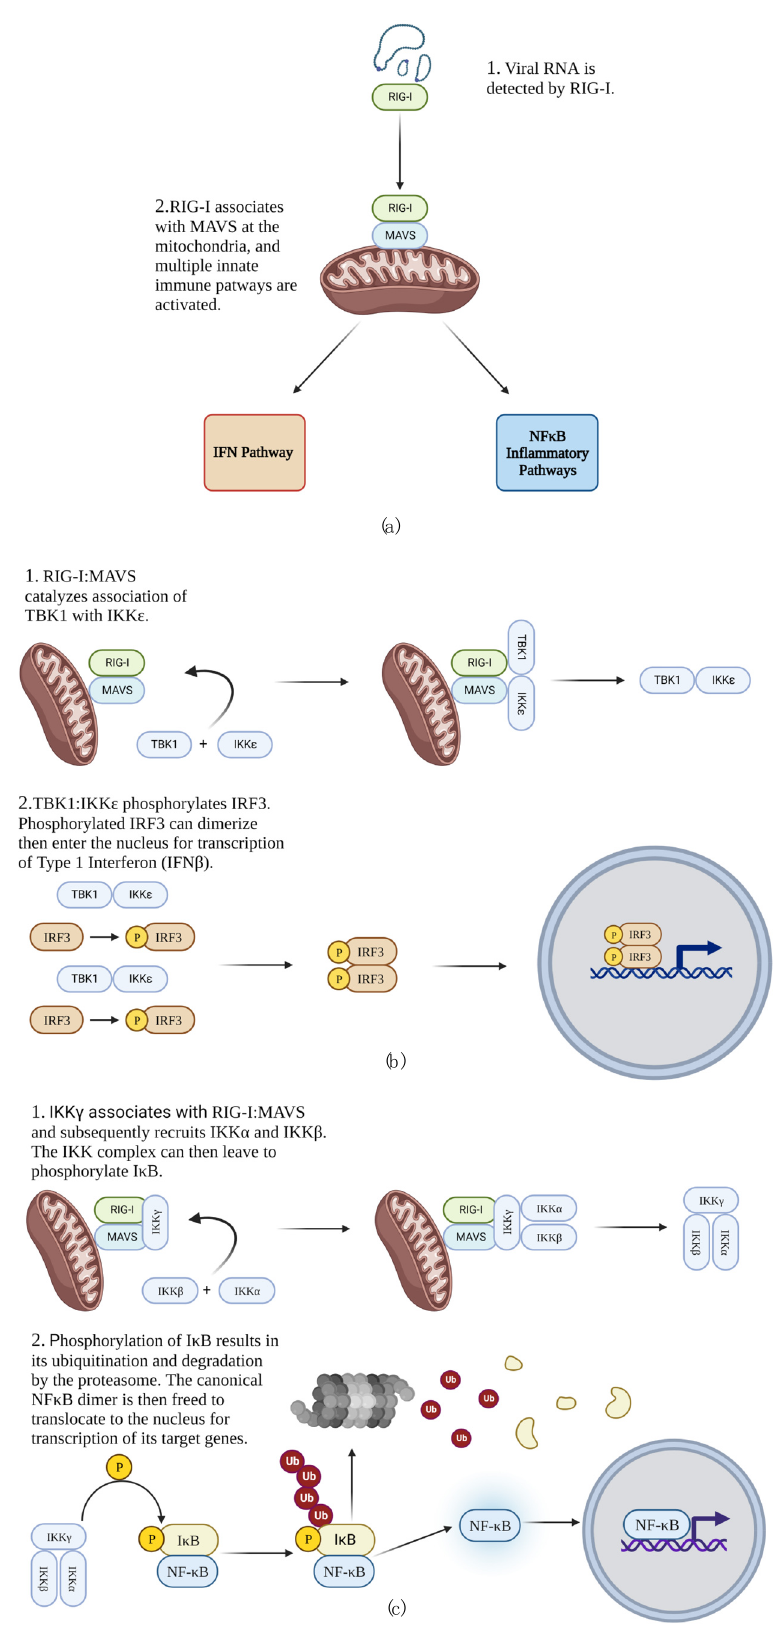
Figure 1. RIG-I-mediated innate immune response to RNA virus infection. ( a ) Innate immune pathways activated in response to RNA viral genome. ( b ) IFN response. ( c ) Canonical NF κ B pathway.